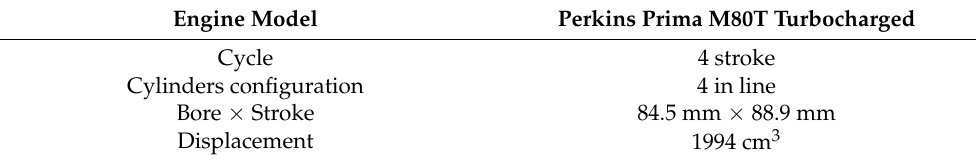
Table 1. Engine specifications (© SAE